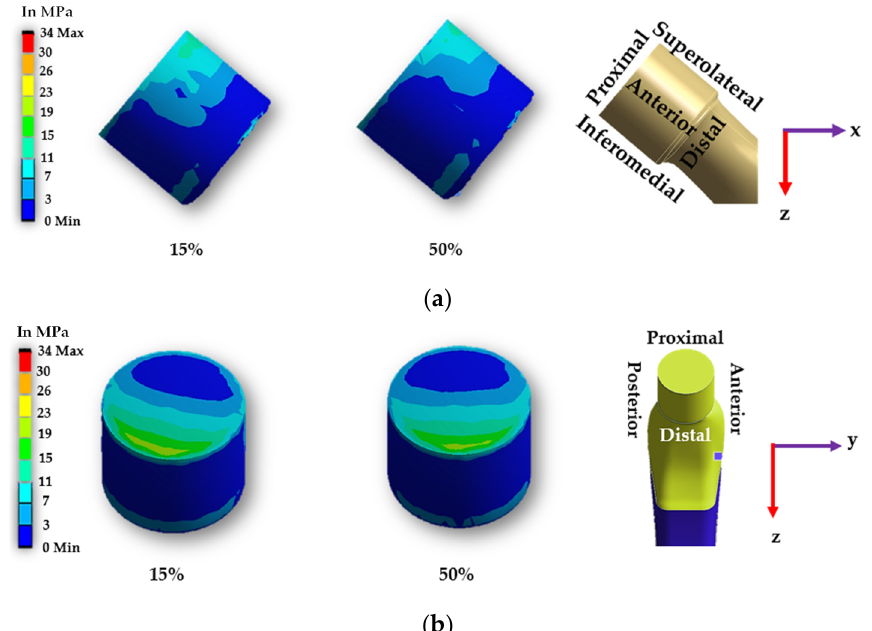
Figure 9. Contact pressure distribution over a smooth head-neck tapered joint from the ( a ) front and ( b ) right side during 15% and 50% of walking loading condition gait cycle.